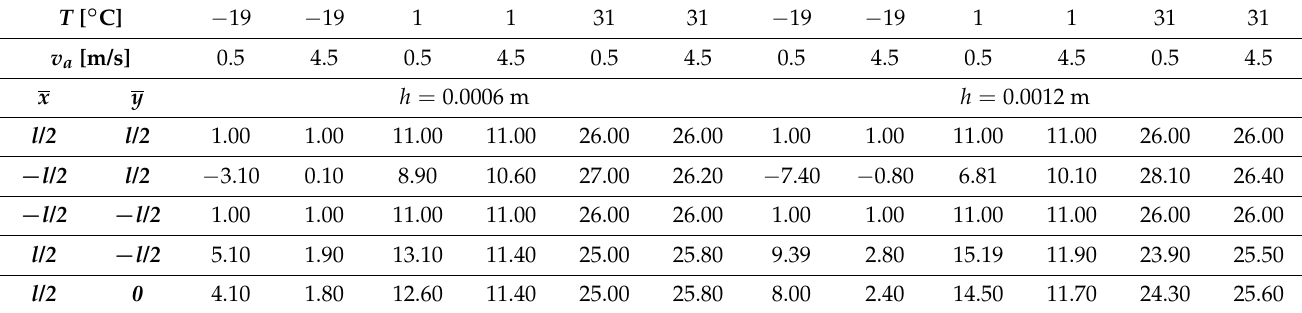
Table 14. Comparison of the temperatures in the corners of a plate and at the midpoint of the plate’s surface facing the heated air inlet to the room, made of 0.0012 m and 0.0006 thick steel plates, for an air exchange duration of t end = 300 s, and air velocities of v a = 0.5 m/s and v a = 4.5